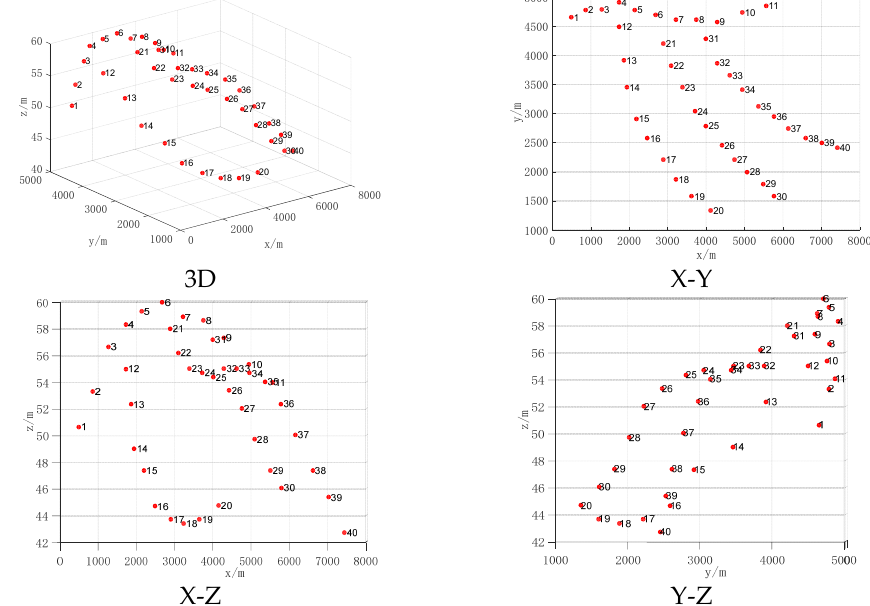
Figure 5. Regional type transmission tower inspection point three dimensional map.